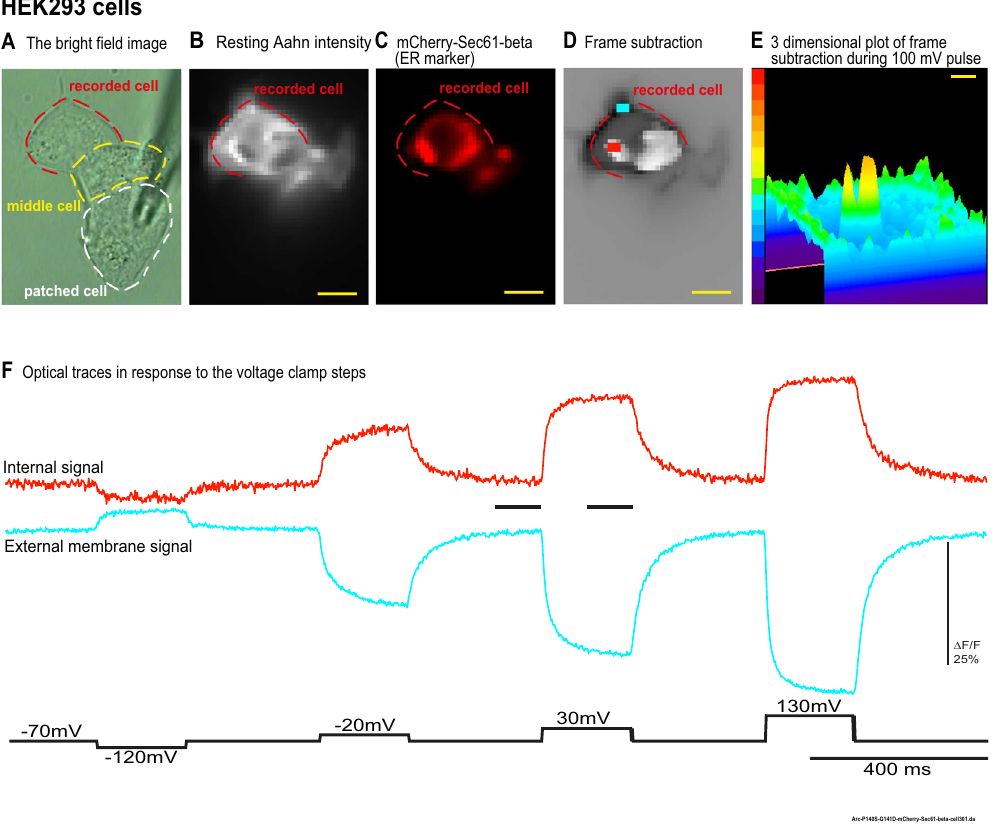
Figure 3. The overlap between an ER marker and the internal signal area in HEK293 cells. HEK 293 cells co- expressing Aahn and mCherry-Sec. 61-beta were voltage-clamped. ( A ) The bright field image of the HEK293 cells. ( B ) The resting light image of the Aahn expression. ( C ) A red florescence protein (mCherry-Sec. 61-beta) was used as a marker for ER. ( D ) The frame subtraction image of the HEK293 cells in response to the 100 mV depolarization pulse (white indicates the internal signal and black indicates the external membrane optical signal). There is a substantial overlap between the area of the internal signal and the ER fluorescence. ( E ) The three dimensional plot of frame subtraction during the 100 mV depolarization pulse ( F ) The red and blue traces are representative fluorescent signals (average of first 4 trials) from internal membrane (red trace) and the plasma membrane (blue trace) respectively without temporal filtering. Images were recorded at a frame rate of 500 fps. Size bars represent 10 μ